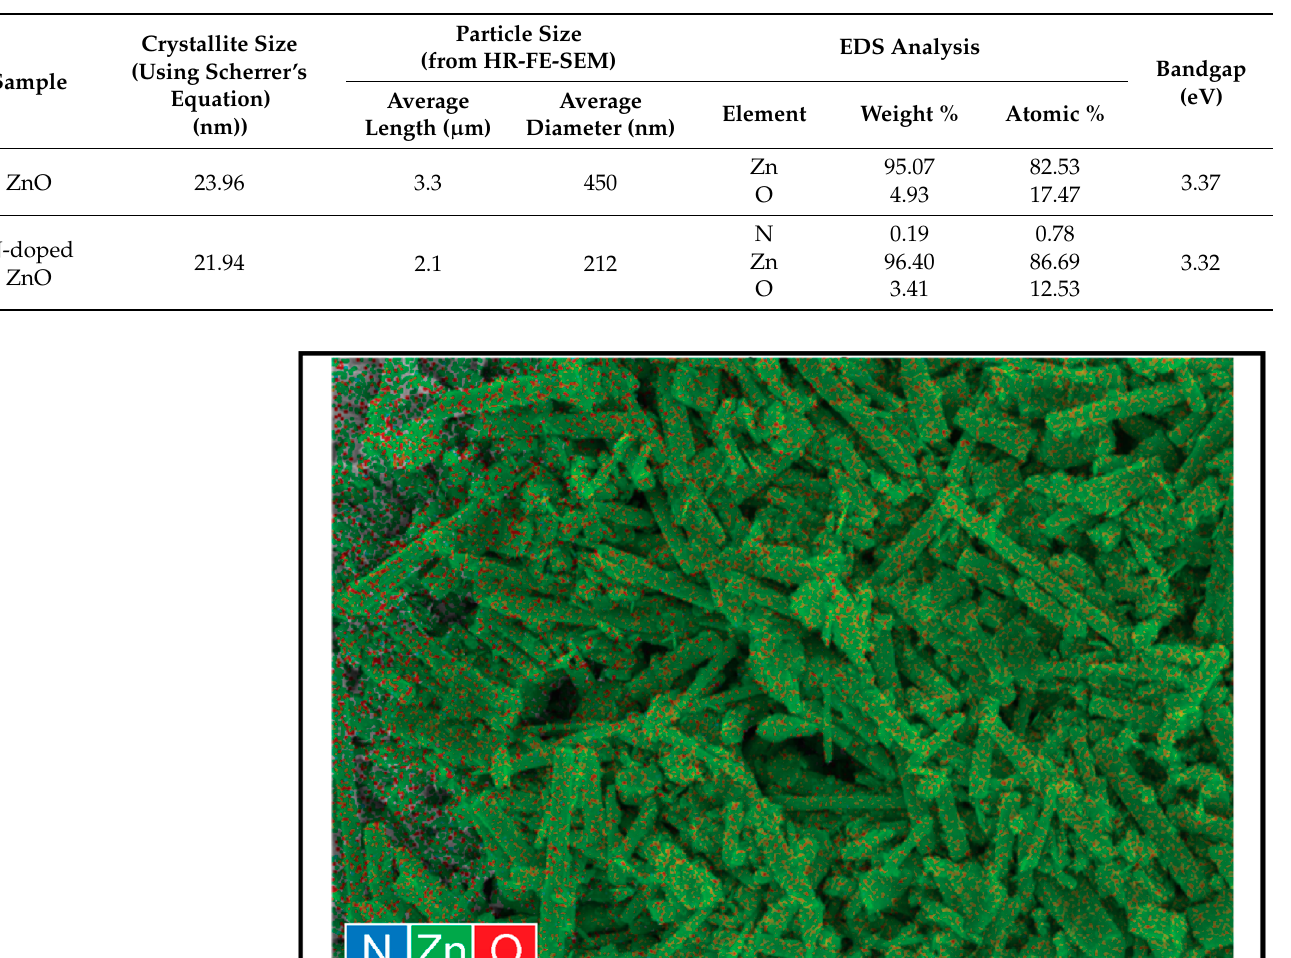
Table 1. Summary of analytical data for ZnO and N-doped ZnO.